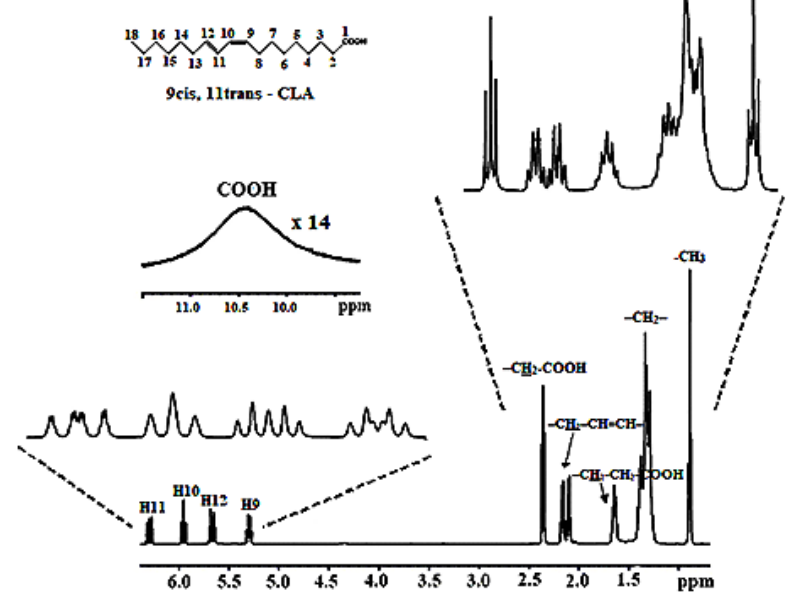
Figure 16. 500 MHz 1D 1 H-NMR spectrum of (9- cis , 11- trans ) 18:2 CLA in CDCl 3 (concentration: 10 mM, T: 298 K, acquisition time: 2.7 s, relaxation delay: 8 s, number of scans: 128, experimental time: ~23 min).